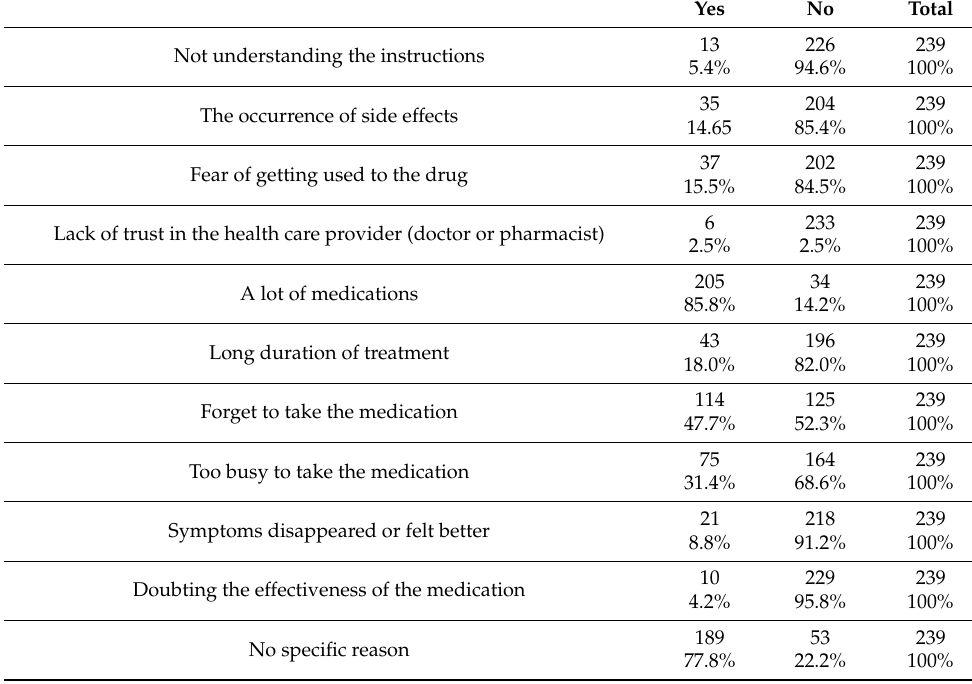
Table 4. Reasons for medication nonadherence.